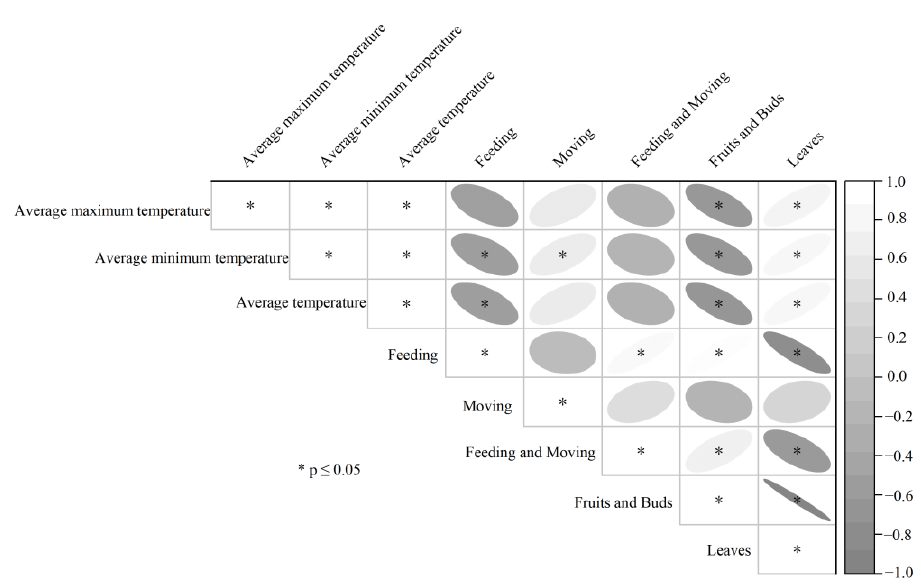
Figure 4. Food, temperature, and time budget correlation.